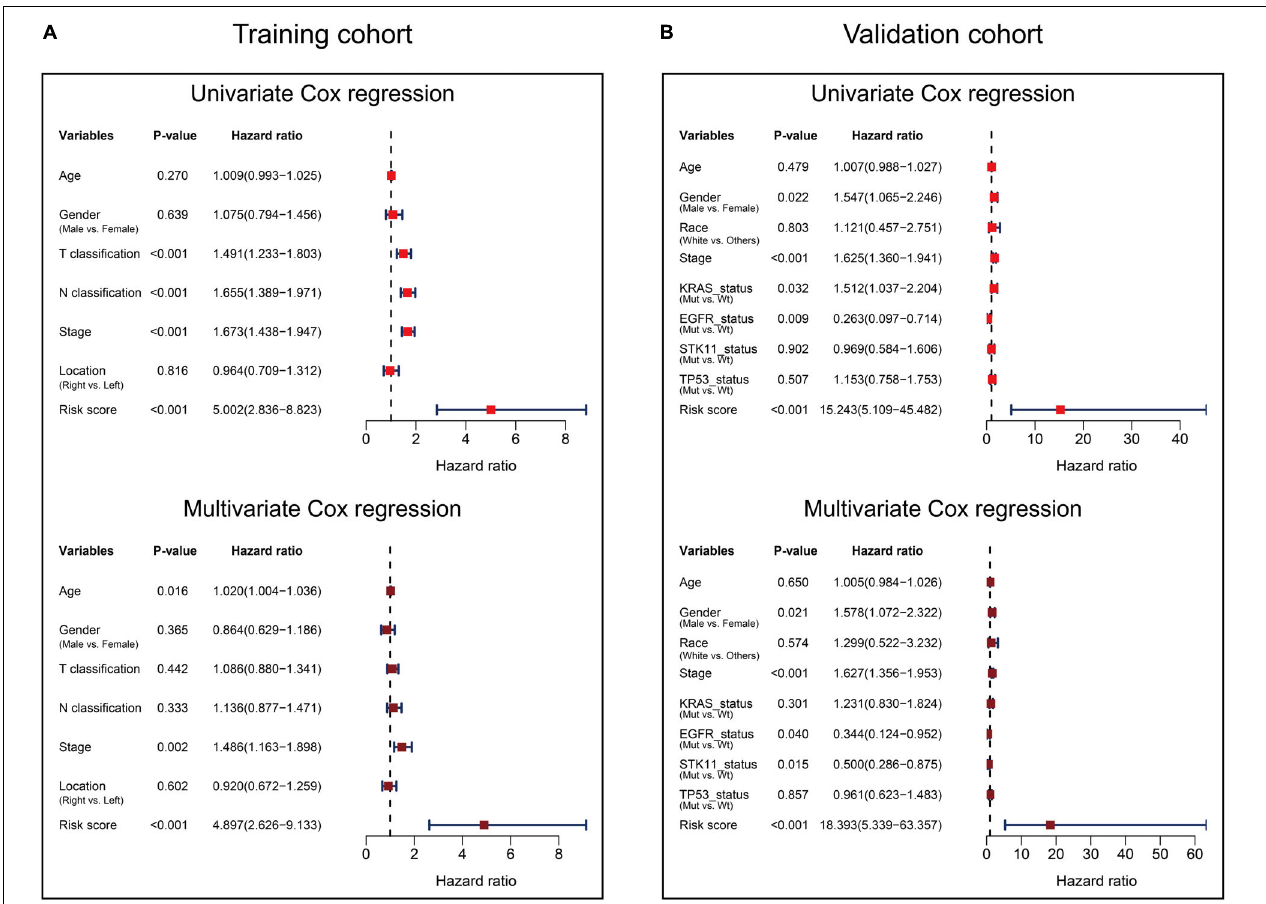
FIGURE 5 | Forest plot summary of Cox analyses of prognosis. Univariate (upper) and multivariate (bottom) analyses based on the eight-gene signature and clinical covariates in training cohort based on overall survival (A) and validation cohort based on overall survival (B) . The colored solid squares represent the hazard ratio (HR), and the transverse lines through HR represent 95% confidence intervals (CI). All p values were calculated using the Cox regression hazards